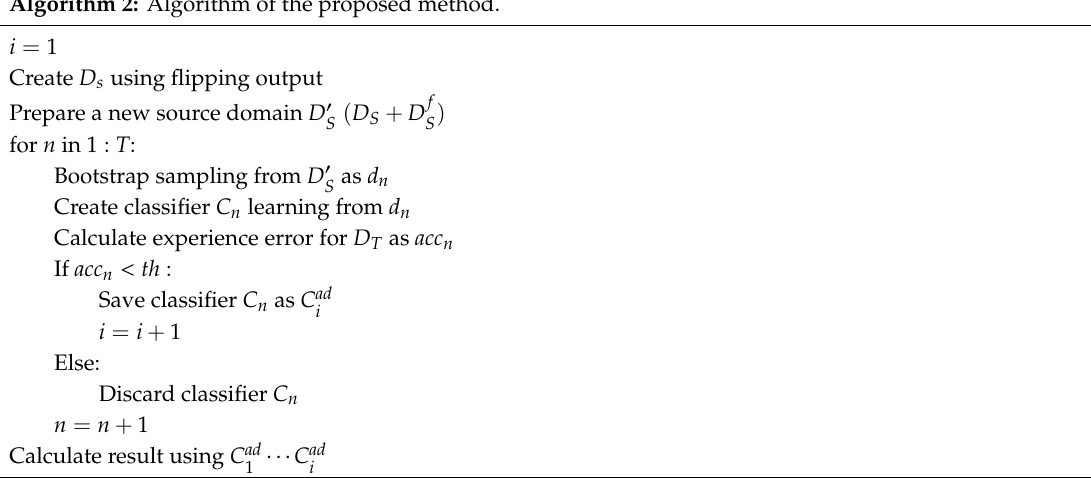
Algorithm 2: Algorithm of the proposed